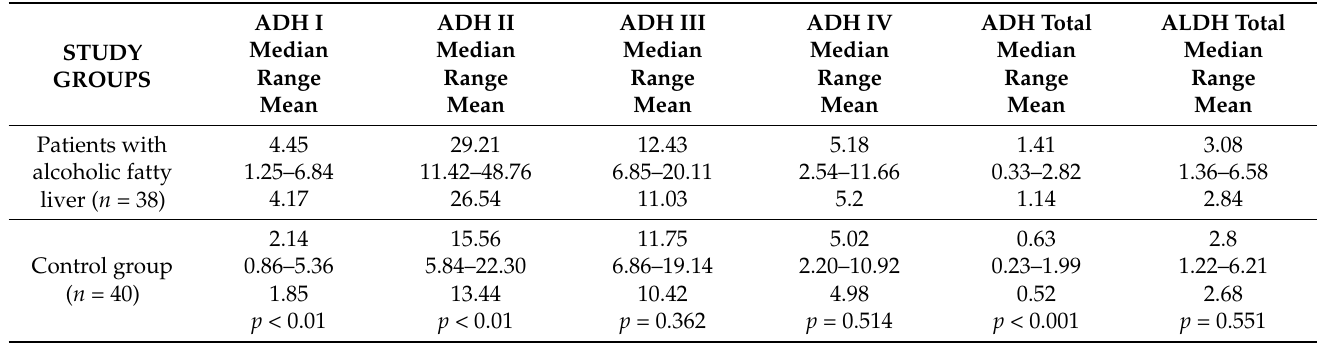
Table 1. Activity of ADH and ALDH in the serum of patients with alcoholic fatty